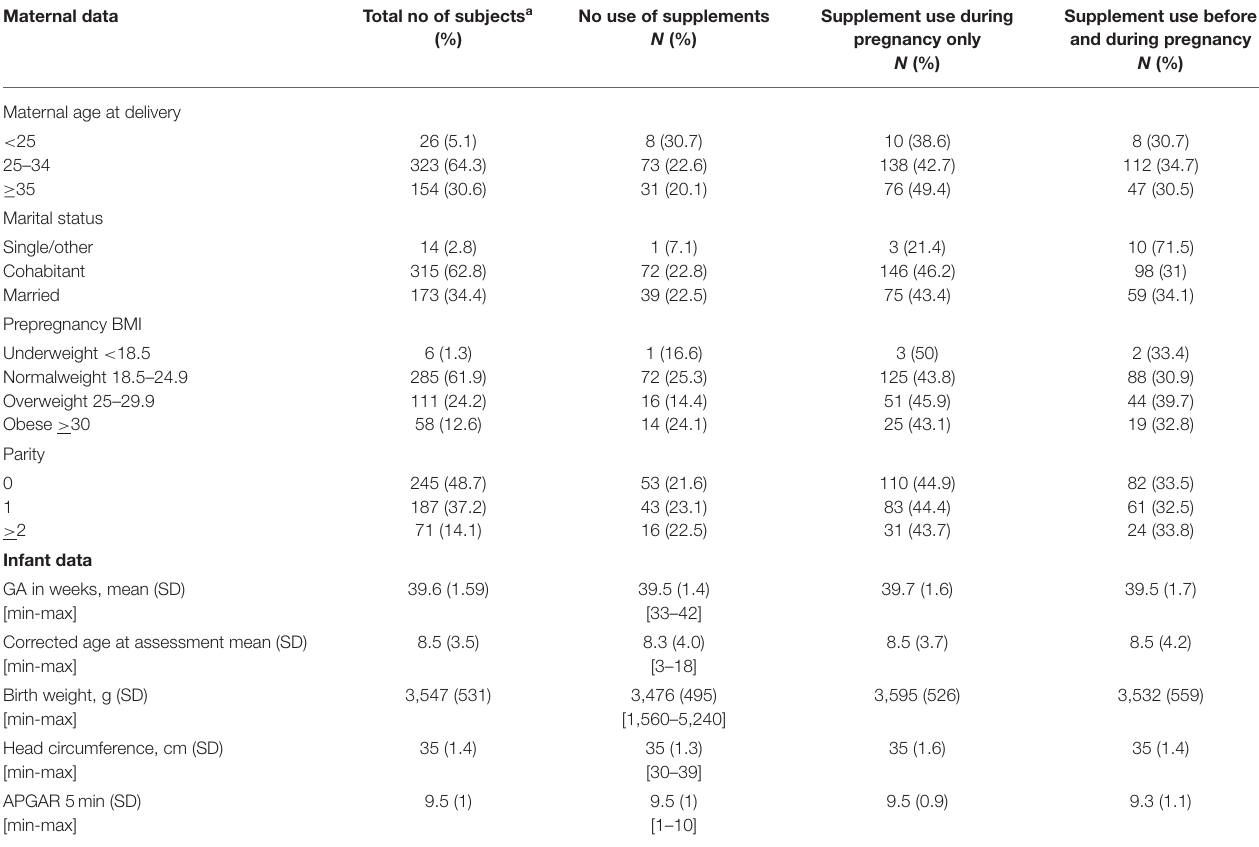
TABLE 1 | Characteristics of participating mothers and